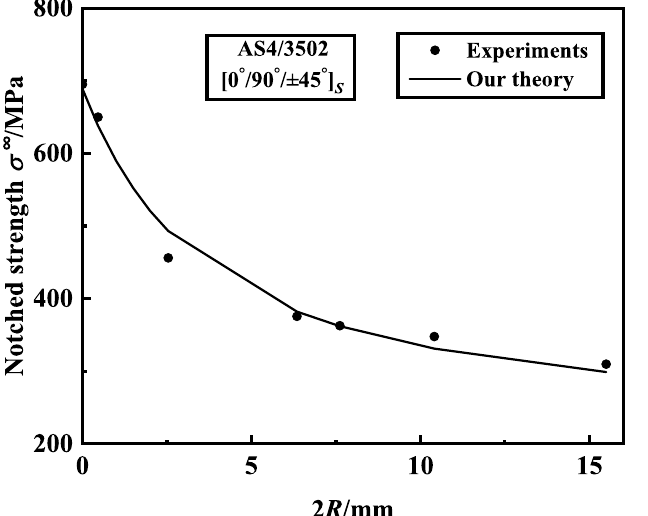
Figure 4. The uniaxial tensile strength of [ 0 ◦ /90 ◦ / ± 45 ◦ ] hole diameters. For a fixed plate width ( W = 152.4 mm), the crack extension at failure l decreases with increase of the hole size as shown in Figure